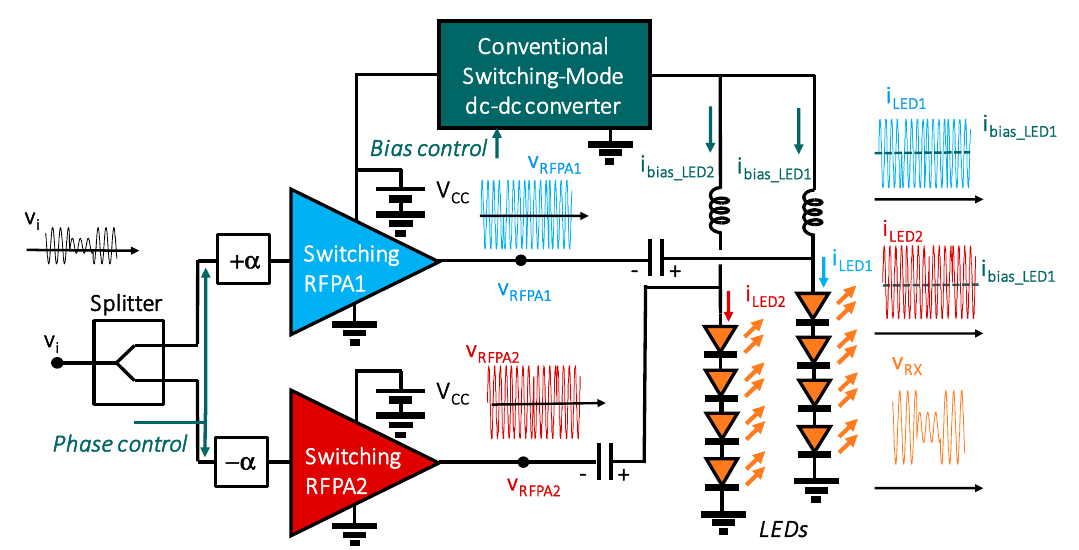
Figure 6. Adapting the Outphasing technique to a VLC-LED driver exploiting summing the light. This scheme is only valid for narrowband approaches.